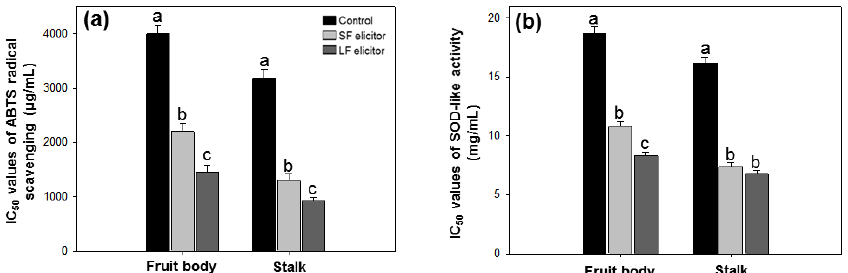
Figure 5. IC 50 values of ABTS radical scavenging ( a ) and SOD-like activity ( b ) of aqueous extracts of Sparassis latifolia after alginate elicitation. SF: Solid fraction of Sargassum fusiforme ; LF: Liquid fraction of S. horneri ; Control: distilled water. The data were analyzed using analysis of variance (ANOVA) followed by Duncan’s multiple-range test ( p < 0.05) using SPSS software (SPSS, Chicago, IL, USA). Error bars indicate the mean ± SD and di ff erent letters describe great di ff erences within the same part of S. latifolia (fruit body and stalk).